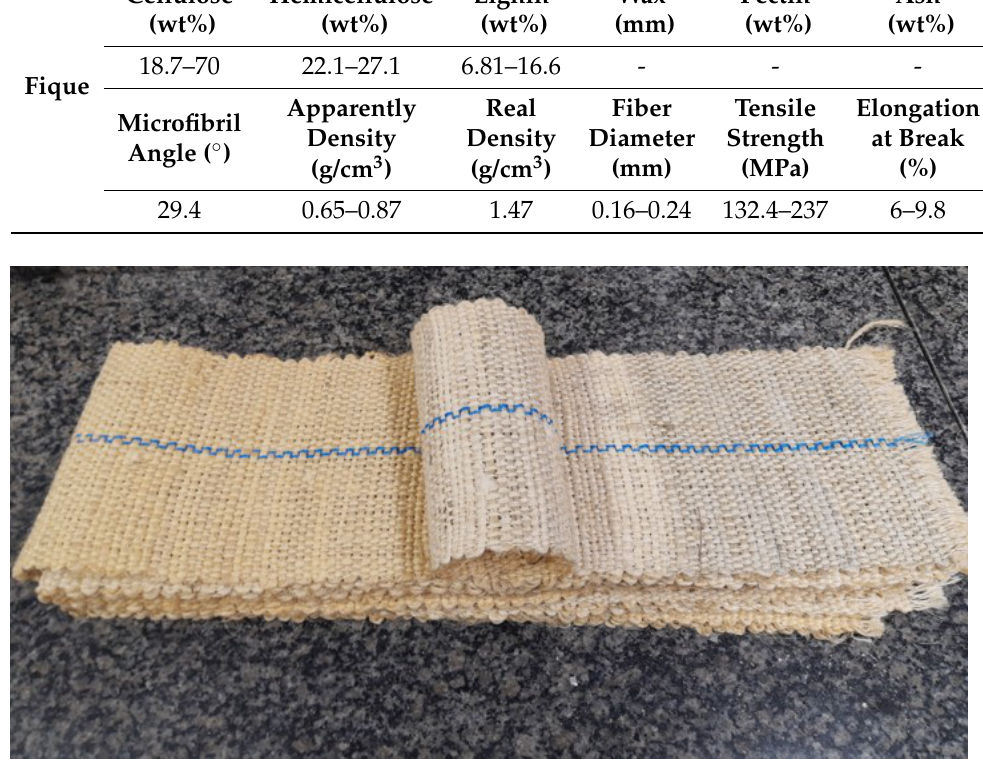
Figure 1. Fique fabric